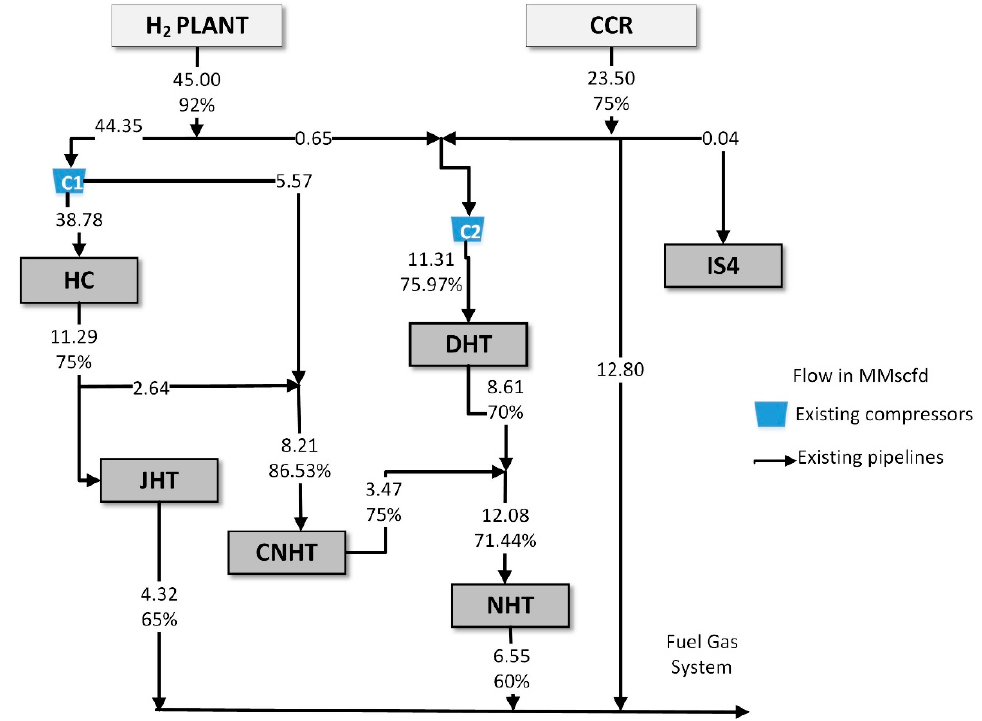
Figure 4. Existing hydrogen network for Example 1. Table 3. Flowrate, purity, and pressure information used in Example 1.